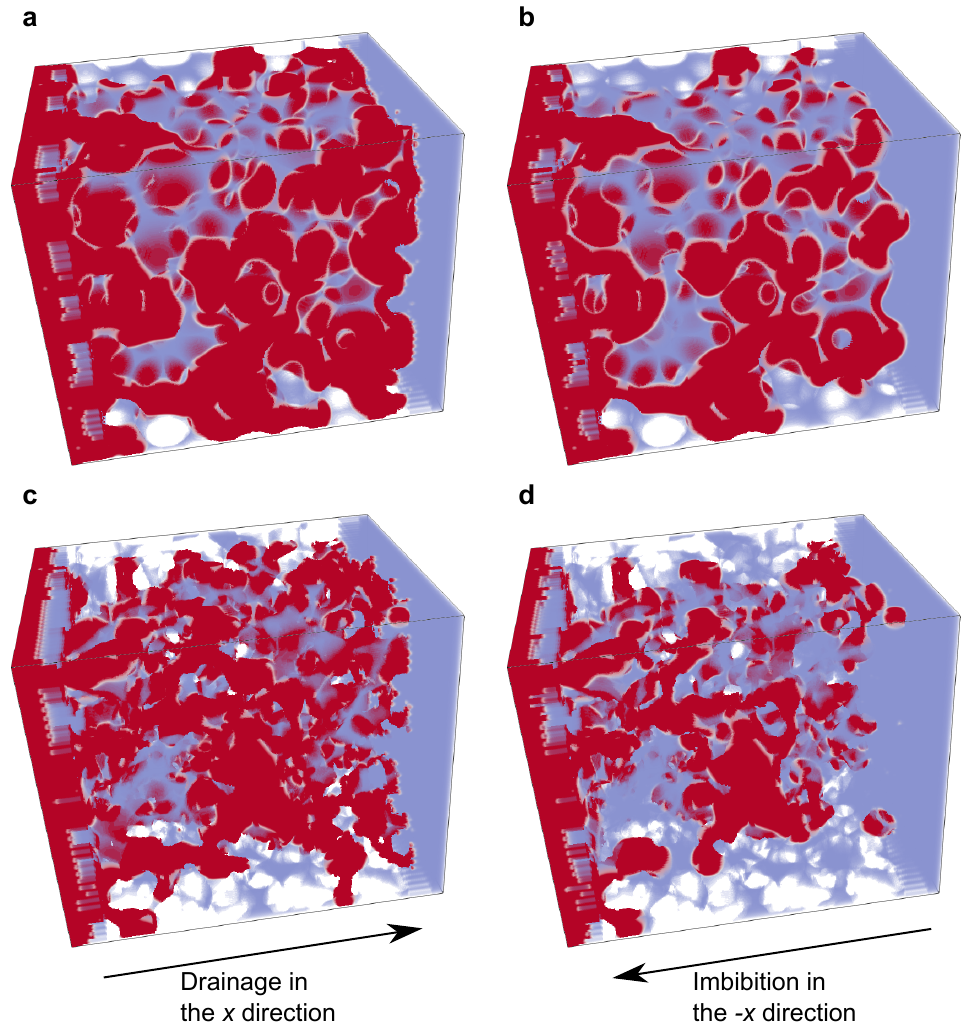
Figure 12. Fluid configurations at the end of ( a ) the drainage in the bead pack, ( b ) imibibition in the bead pack, ( c ) drainage in the Bentheimer sandstone and ( d ) imibibition in the Bentheimer sandstone. Here, oil and water are shown in red and transparent blue, respectively. The drainage simulations were performed from left to right, while the imbibition simulations were performed from right to